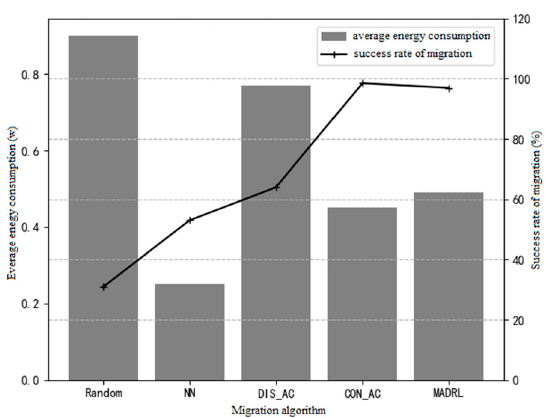
Figure 6. Average energy consumption and migration success rate of different migration strategies.